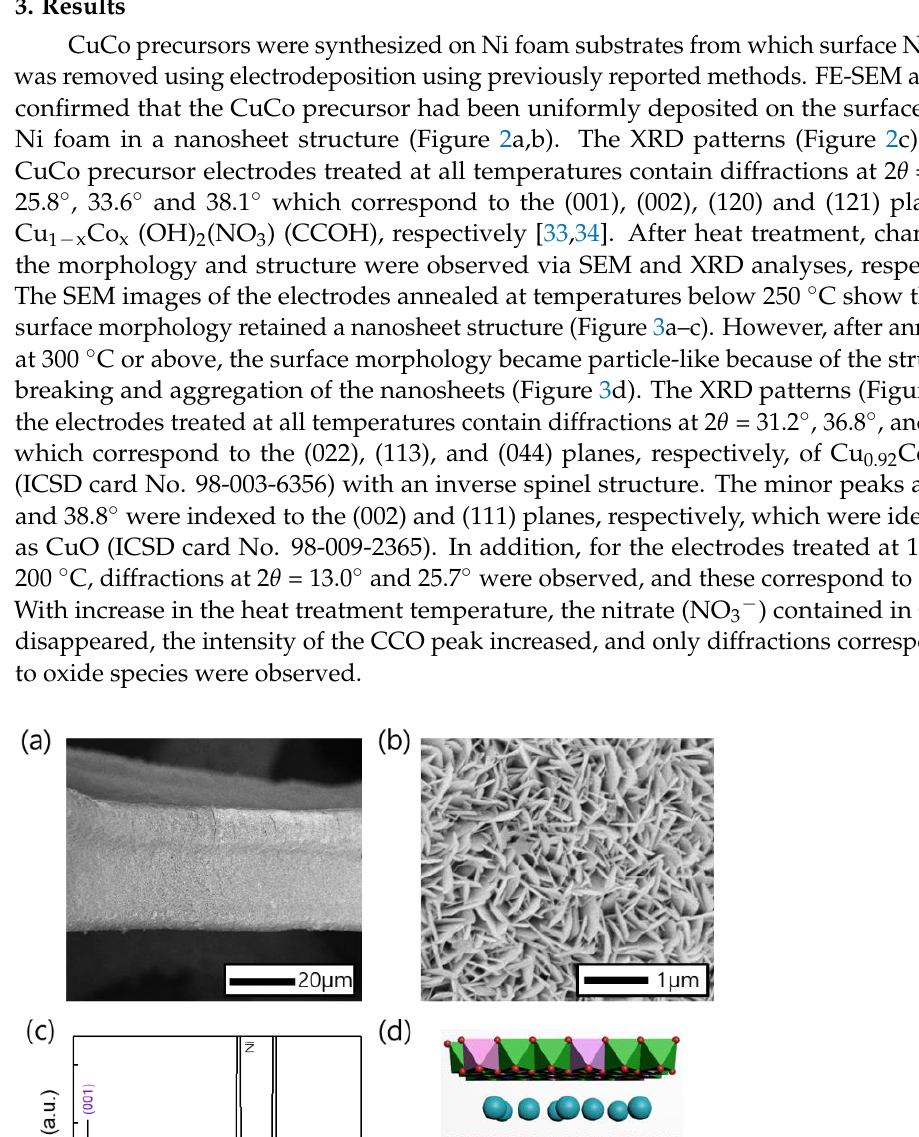
Figure 3. SEM images showing the changes in CCO morphology with temperature: ( a ) 150, ( b ) 200, ( c ) 250, and ( d ) 300 °C, respectively.